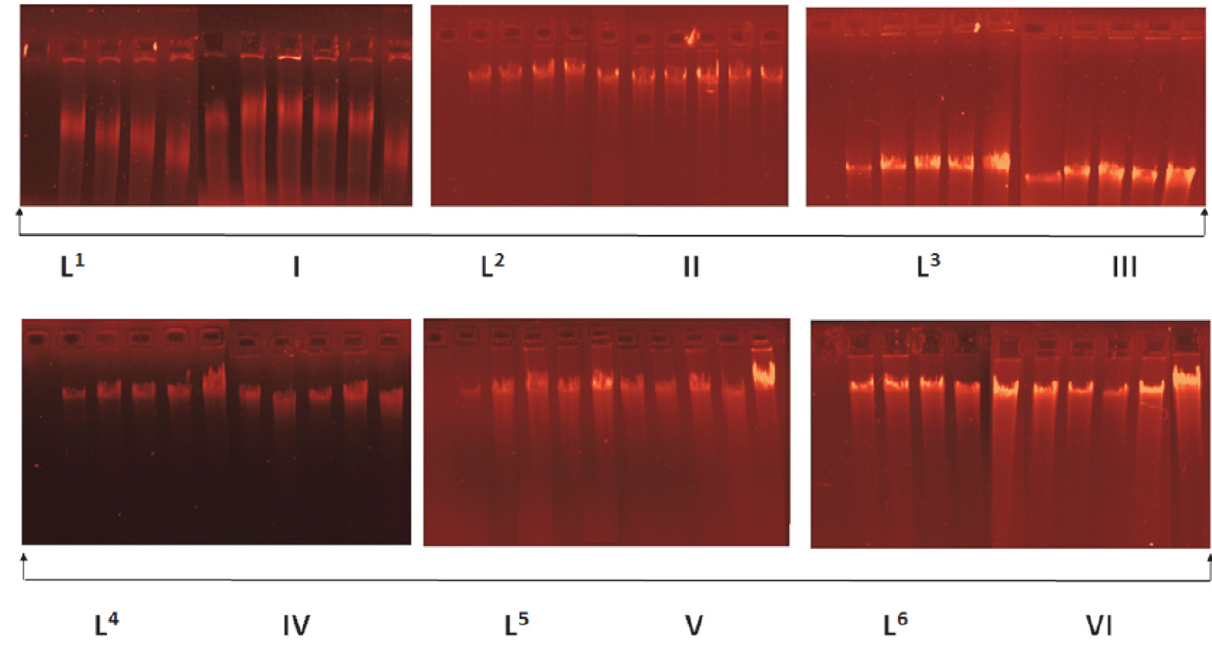
Figure 8. Photogenic view of the cleavage of S. cerevisiae DNA with a series of compounds using % agarose gel containing 0.5 μg/L EtBr for 24 h at 37